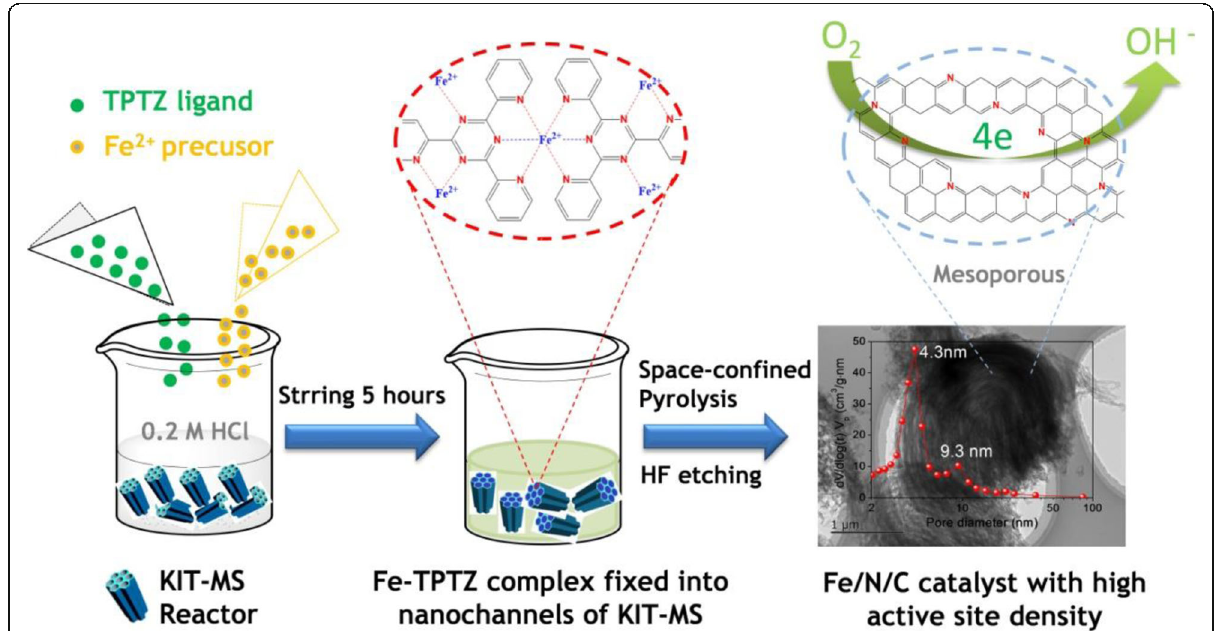
Fig. 1 A schematic drawing for the synthesis of mesoporous Fe/N/C